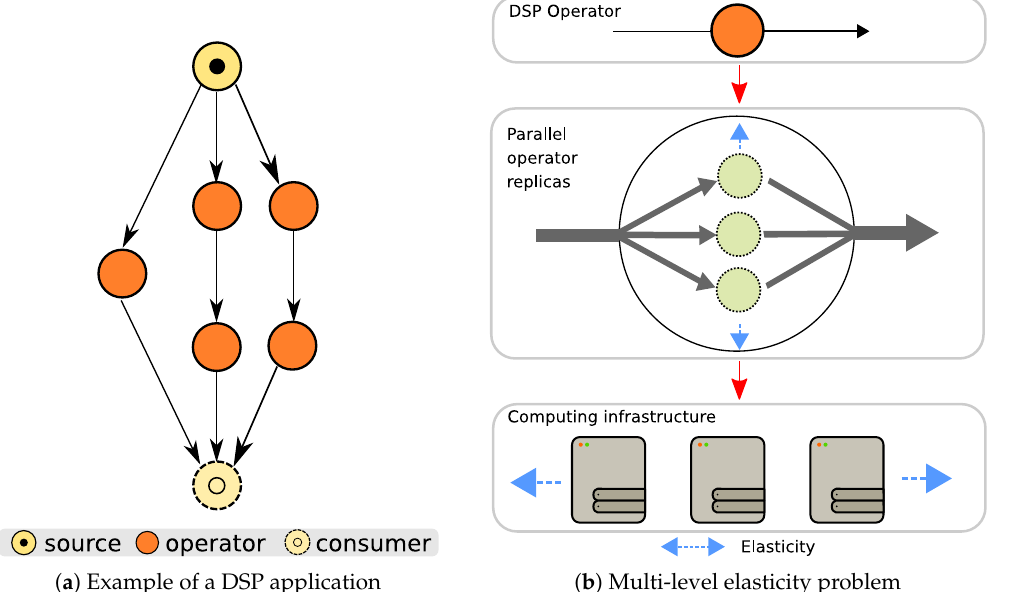
Figure 1. Model of a DSP application and representation of the multi-level elasticity problem: the application operators (i.e., vertices of the application DAG) should be conveniently replicated at run-time, to satisfy performance requirements, and deployed over an elastic set of computing